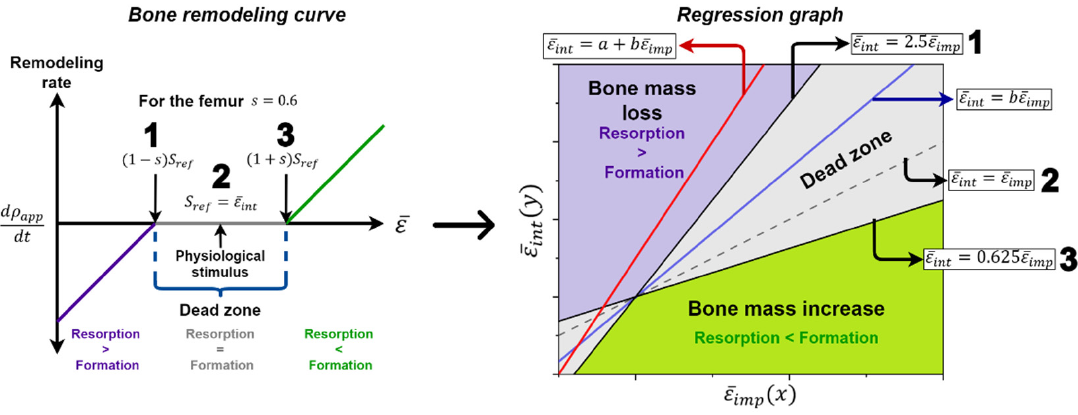
Figure 12. Remodeling curve and regression graph.